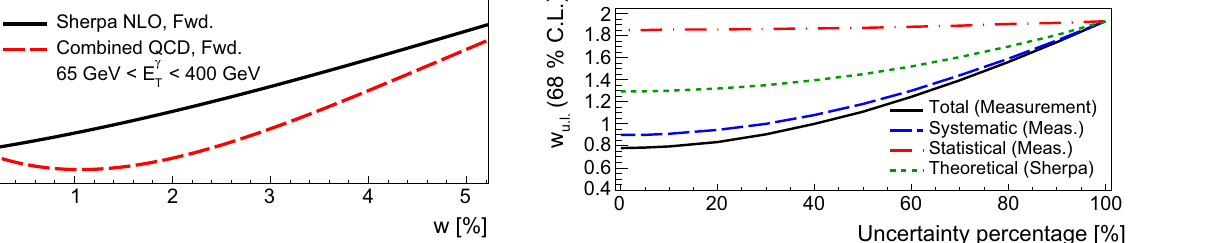
Fig. 4 The dependence of the IC upper limit w u . l . at 68 % CL on the uncertainty percentage of the particular uncertainty component